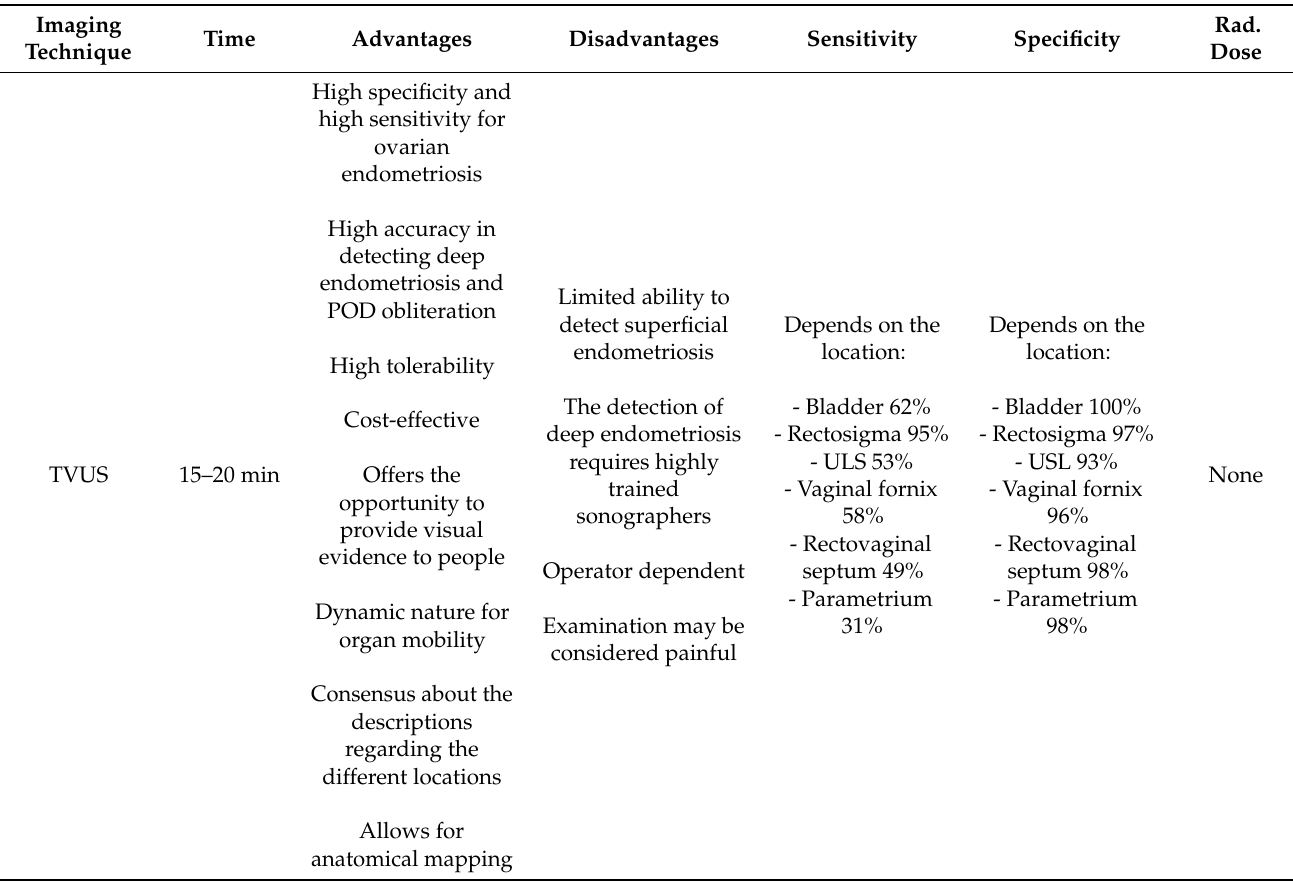
Table 2. The advantages and disadvantages of the different imaging techniques used for the diagnosis of